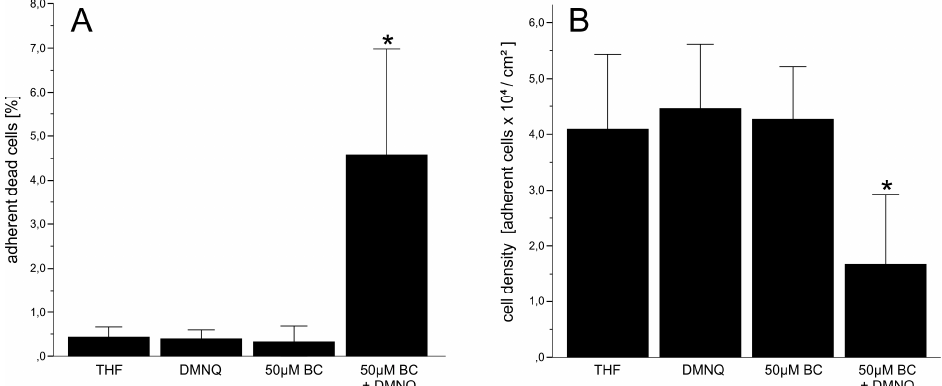
Figure 4. ( A ) Adherent dead cells and ( B ) changes of cell density in pneumocyte type II cell cultures treated with different concentrations of BC in the presence of 5 µM DMNQ. Data represent the means ± SD of at least 3 independent experiments; *: p < 0.05 compared to all controls.